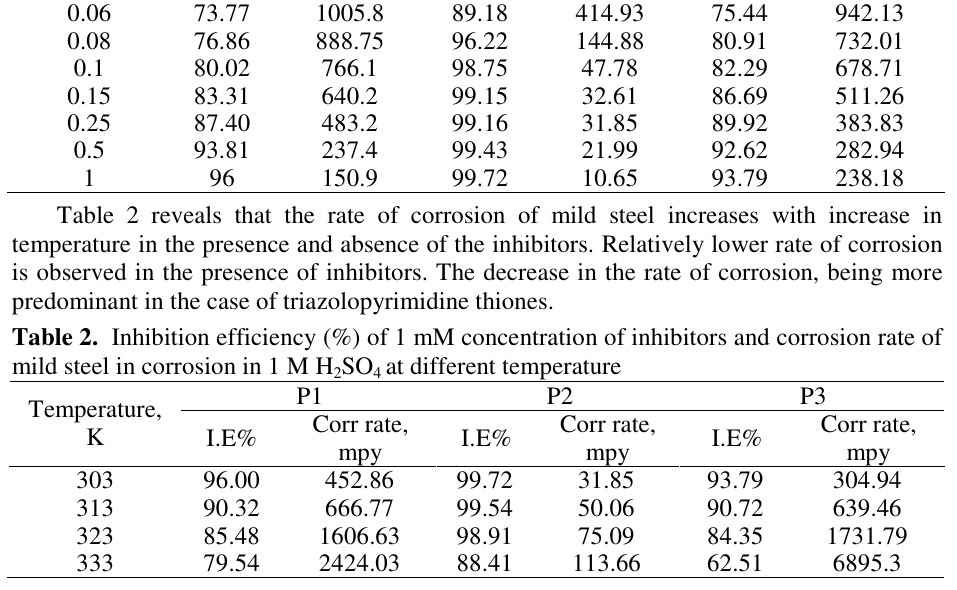
SO at different 2 4